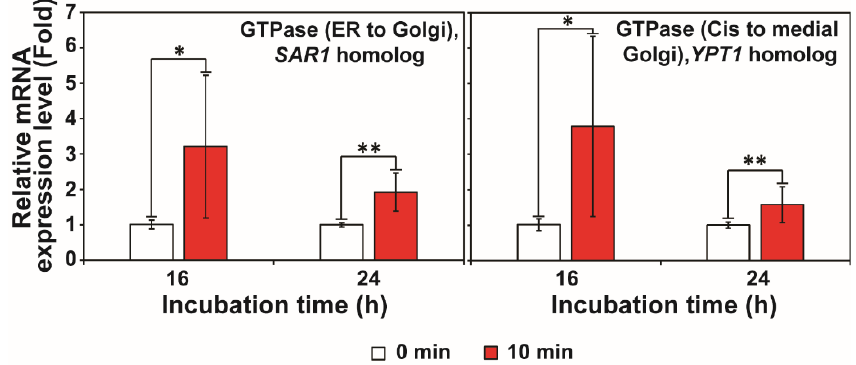
Figure 5. Transcription level of genes involved in regulating cellular trafficking in A. oryzae after exposure to RF-EMF (2 GHz, 0.01 W). Each value represents the mean of nine replicate measurements. The experiment was repeated three times, each with three replicate measurements: * p < 0.05 and ** p < 0.01.